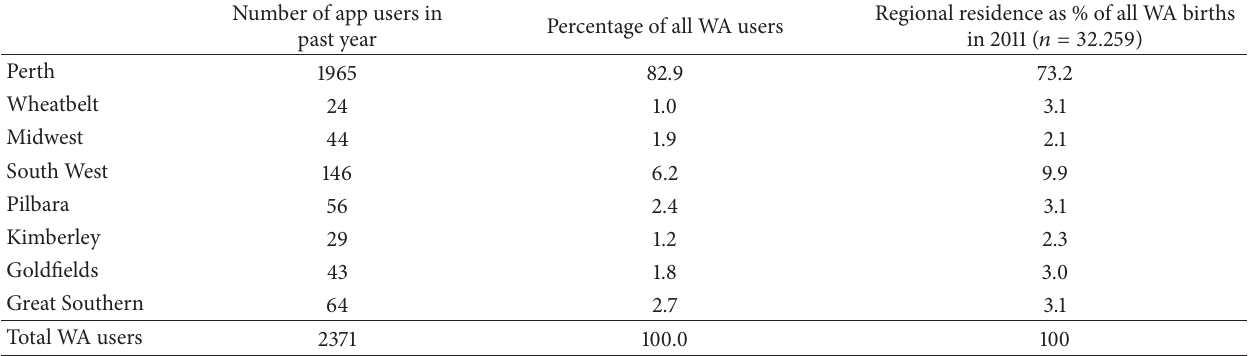
Table 3: Number and percentage of app users and percentage of Western Australian births per year by mother’s region of residence.